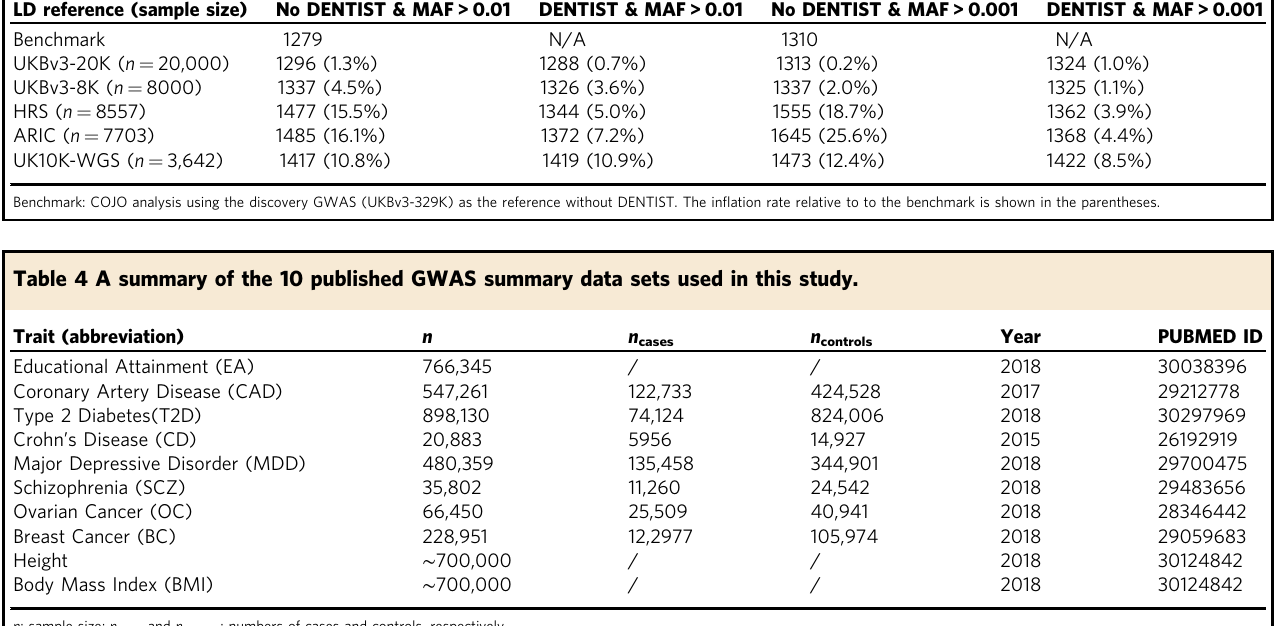
Table 3 Numbers of COJO signals from analyses of the UKB height summary data using different LD reference samples with and without DENTIST-based QC.